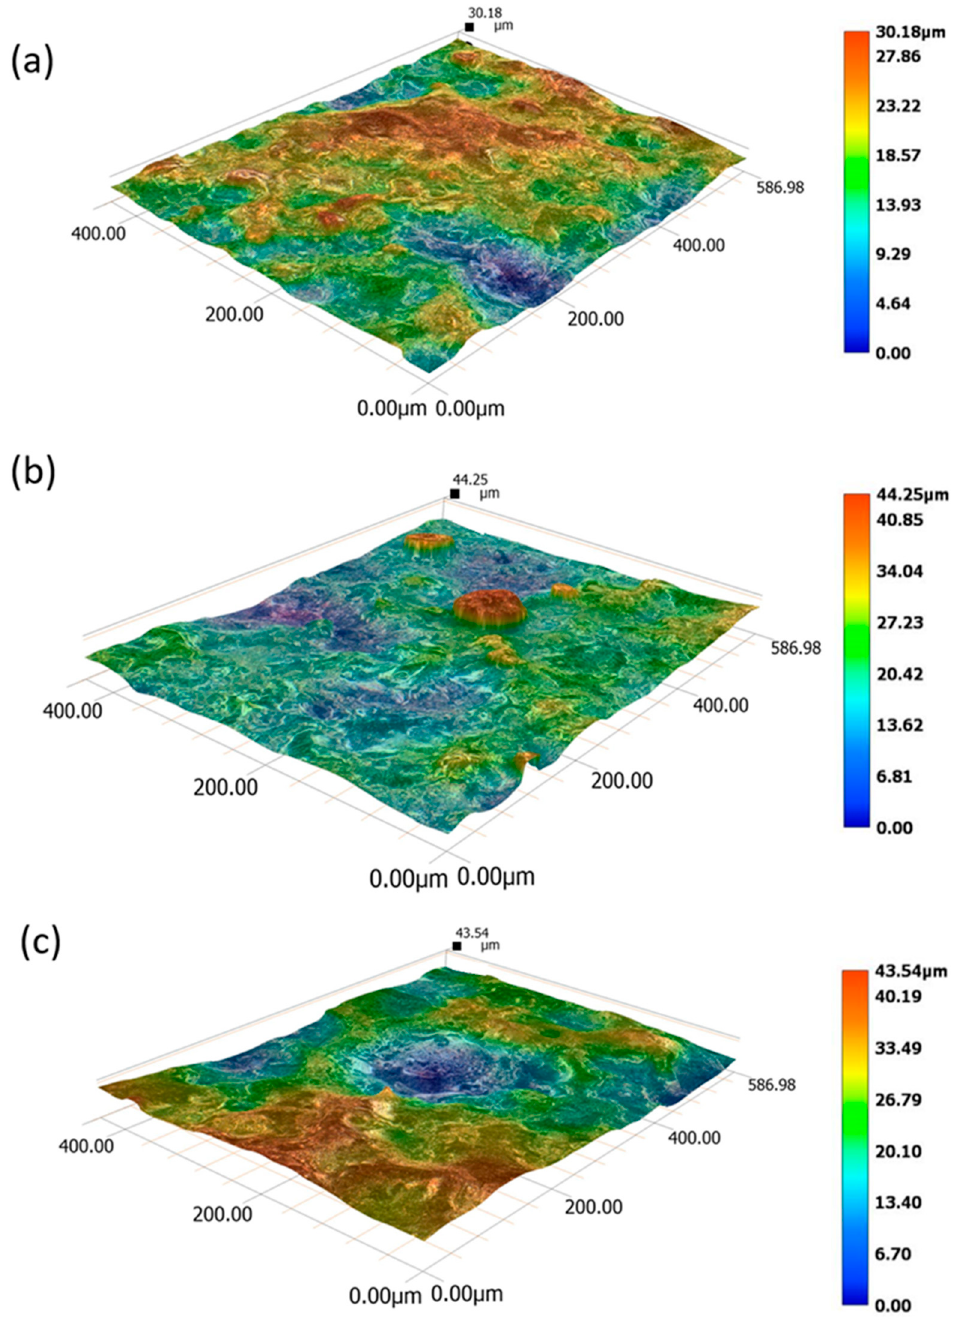
Figure 2. Surface topography of the machined surface based on the FVM for ( a ) Ip = 5 A, Ton = 12.8 µ s and SRa = 3.72 µ m, ( b ) Ip = 7 A, Ton = 25 µ s and SRa = 4.89 µ m and ( c ) Ip = 9 A, Ton = 50 µ s and SRa = 6.29 µ m.